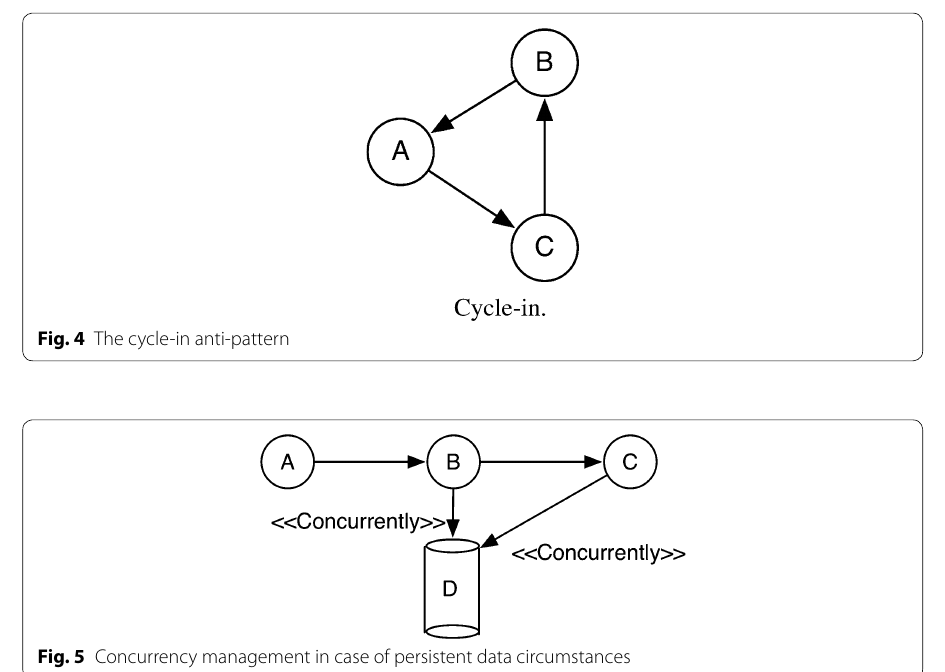
Fig. 5 Concurrency management in case of persistent data